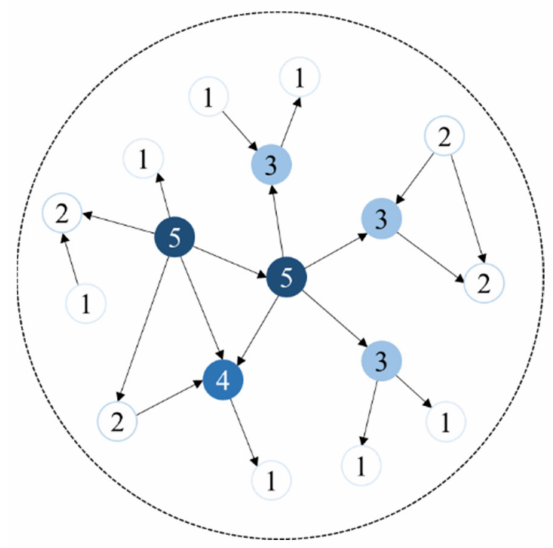
Figure 4. Solution process for graph-neighbor fault entity